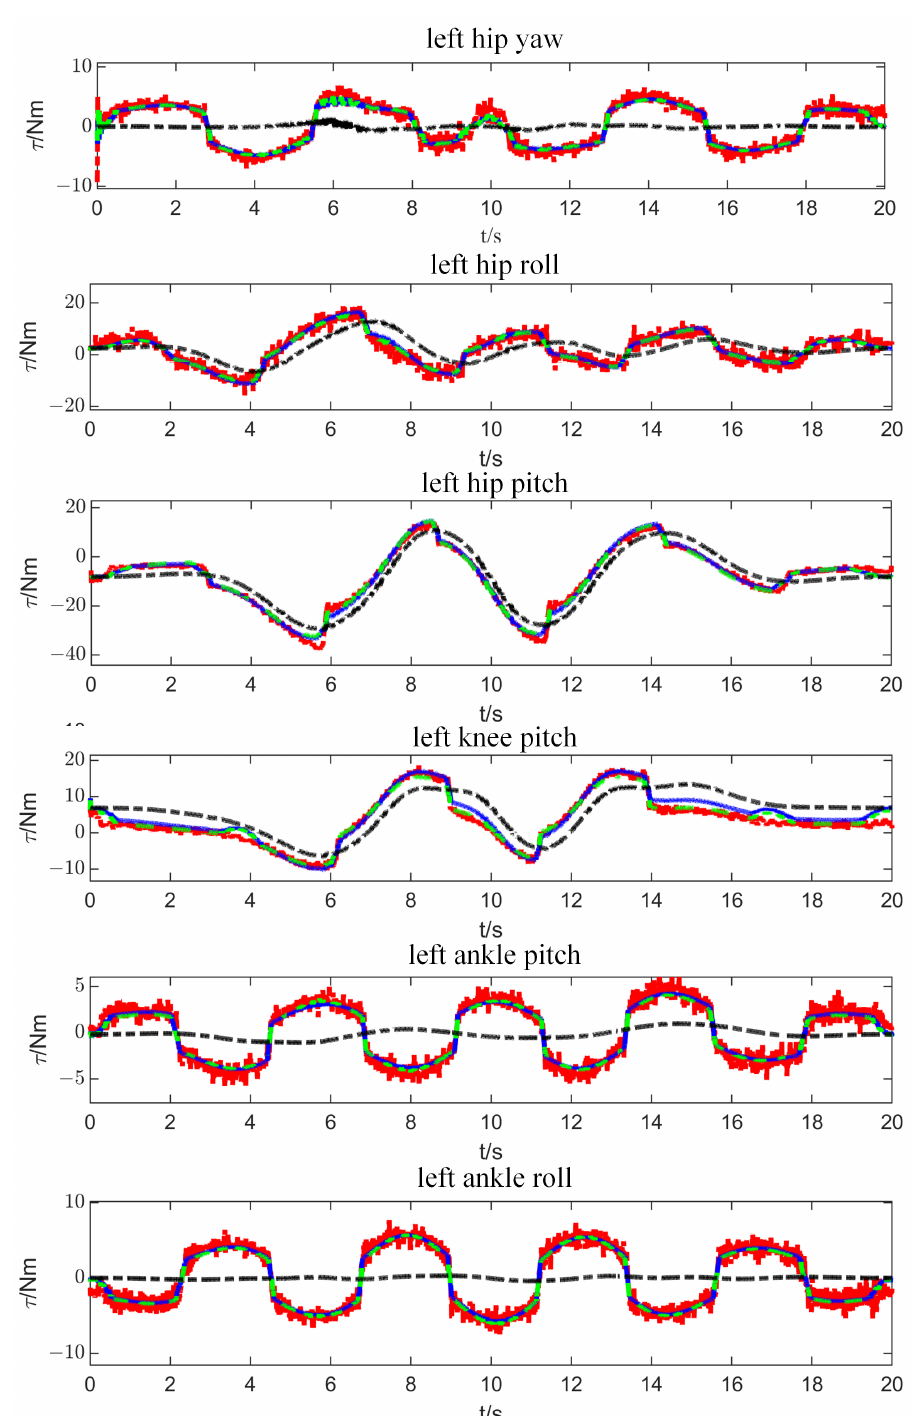
Figure 5. The comparison of joint torque in the left